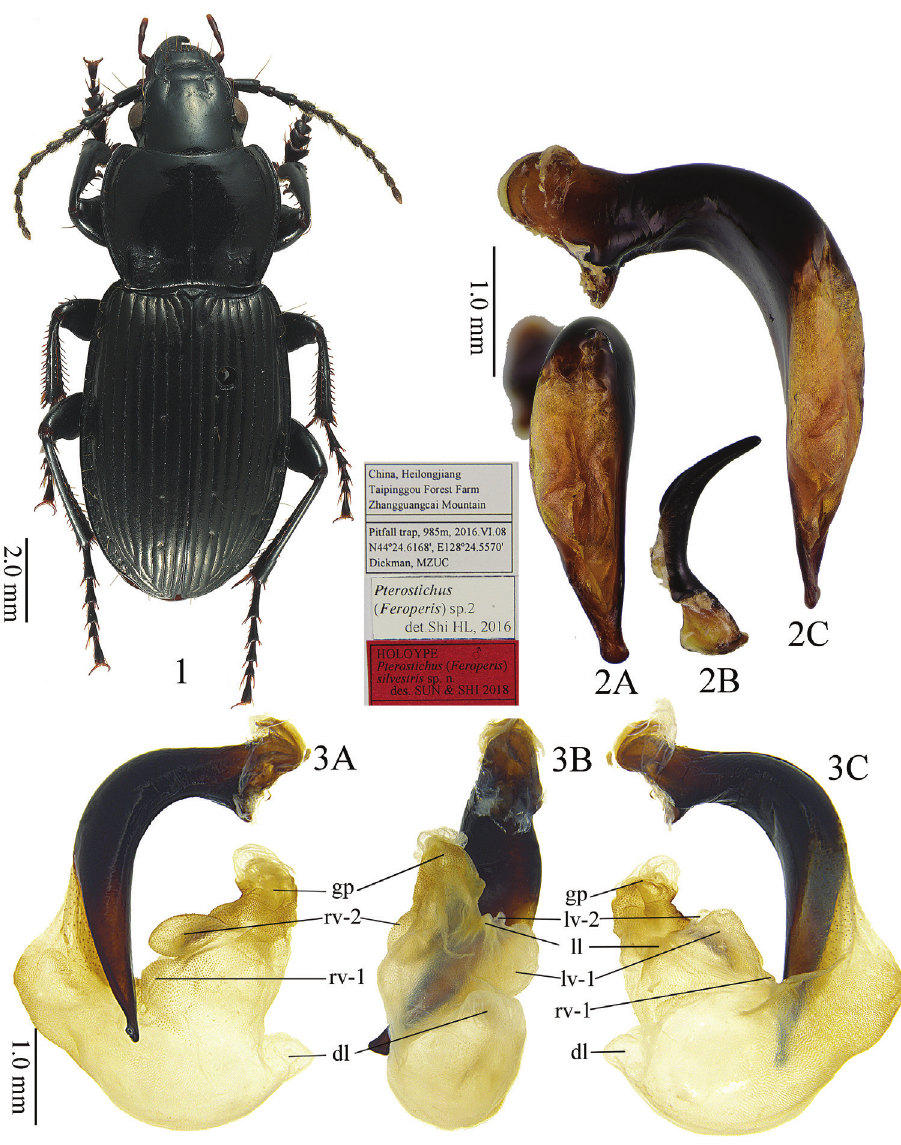
Figures 1–3. Pterostichus ( Feroperis ) silvestris sp. n. 1 Habitus and labels of holotype 2 Male genitalia of holotype A dorsal view of median lobe, B right paramere, C left lateral view of median lobe 3 Endophallus of a paratype A right lateral view, B ventral view, C left lateral similar or less wide as lateral border of the pronotum anterior to the posterior angles; carinae between lateral margins and pronotal basal foveae strong, parallel to the fine median line. Basal foveae moderately deep, clearly defined throughout except at the basal area, outer basal foveal groove long and deep, reaching the posterior margin of